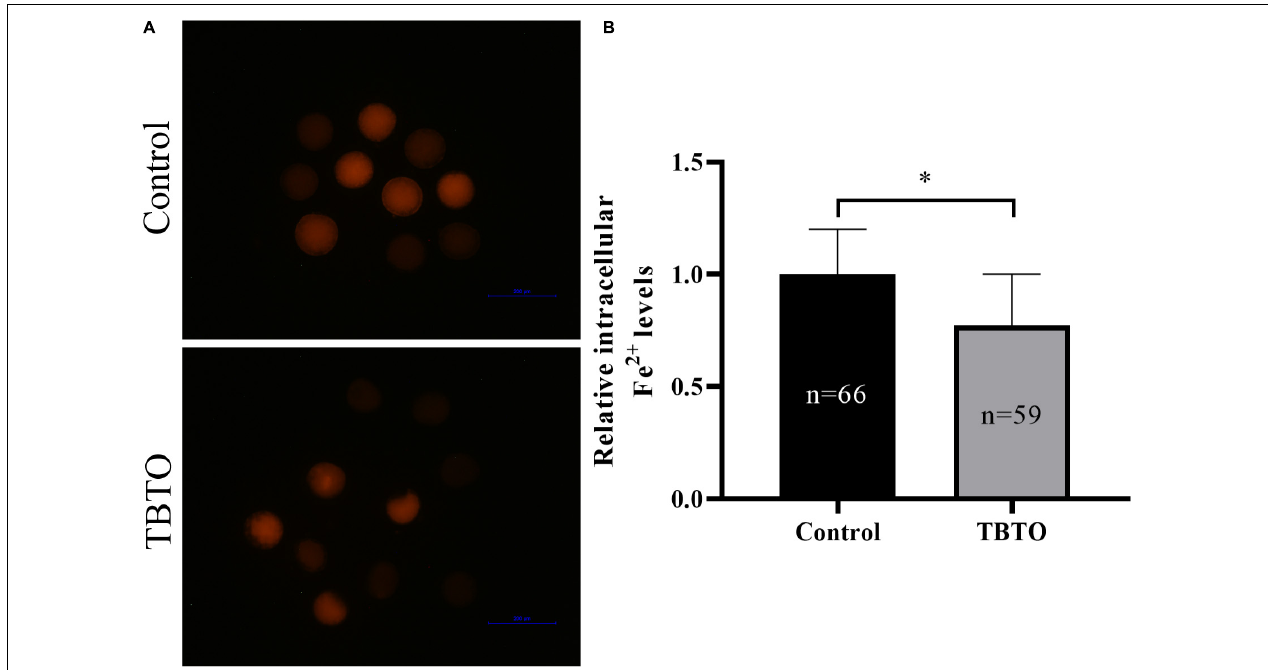
FIGURE 6 | Effect of TBTO exposure on iron homeostasis in porcine oocytes. (A) Representative fluorescence images showing intracellular ferrous ion levels in porcine oocytes in the control and TBTO exposure group at the end of the IVM period. (B) Quantification of relative intracellular ferrous ion levels in porcine oocytes from the control and TBTO exposure group. The numbers of oocytes examined from the different groups are indicated by the bars. ∗ p < 0.05 compared to the control.